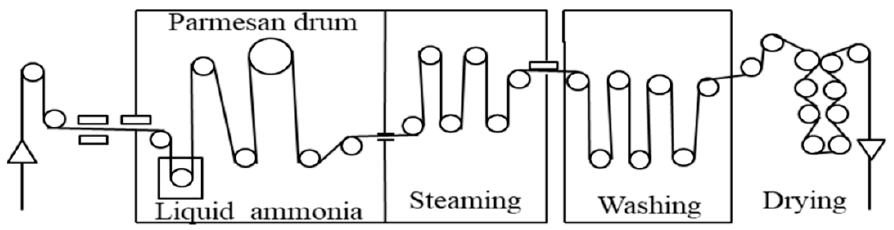
Figure 1. Schematic diagram of a continuous liquid ammonia finishing machine.